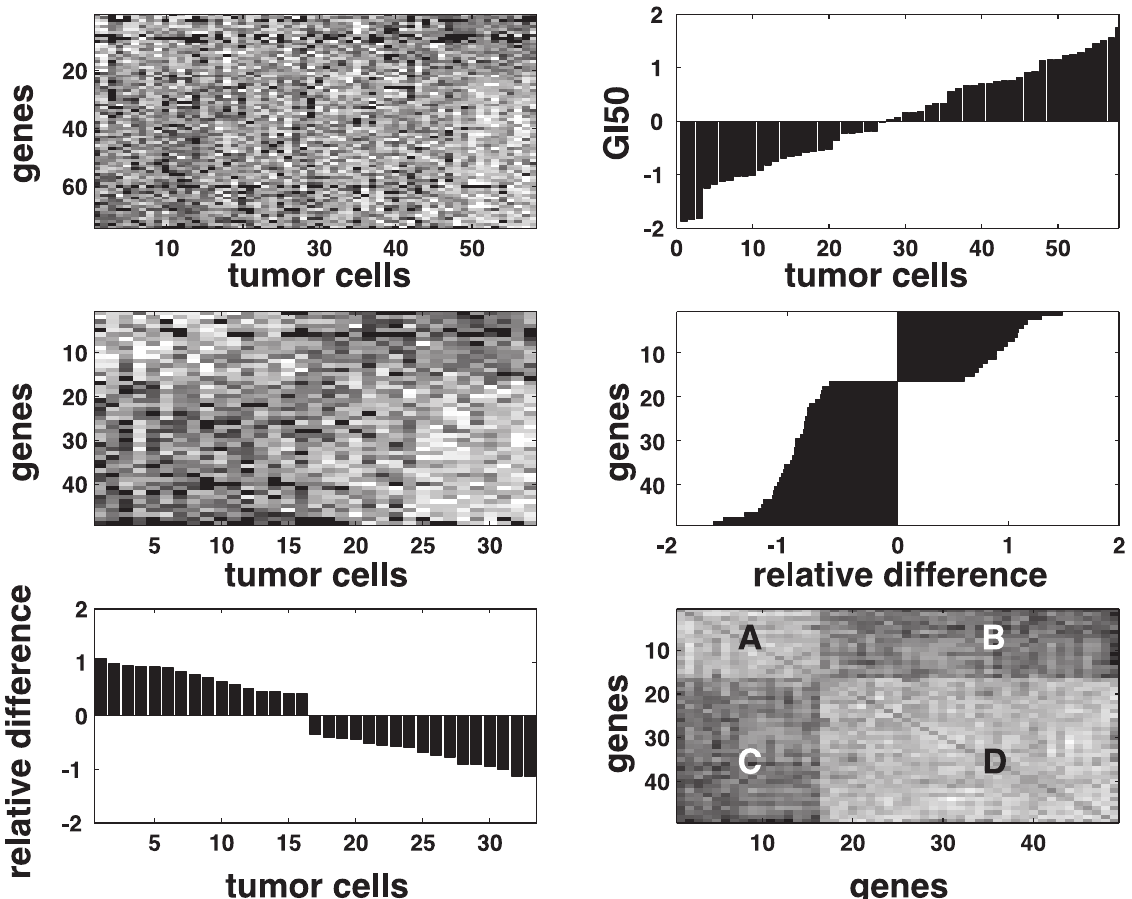
Figure 3. Illustration of the steps for trimming datasets. Upper left panel: row ordered (gene expressions) and column ordered (tumor cells) gene set derived from the topmost 10 th percentile of H-scores for this test example. Upper right panel: ordered chemoactivity profile (insensitive and sensitive tumor cells appear as + and - responses, respectively. Middle left panel: Ordered gene expressions for the trimmed set of discriminating genes. Middle right panel: Group averaged differential in gene expressions for chemo-sensitive and chemo-insensitive tumor cells. Lower left panel: Group averaged differential in gene expressions for over and under expressed discriminating genes. Lower right panel: Pearson correlation values (light:positive, dark:negative) for discriminating gene expressions. Letters correspond to response classes; A: over expressed/insensitive, B: under expressed/sensitive, C: under expressed/insensitive and D: over expressed/sensitive.